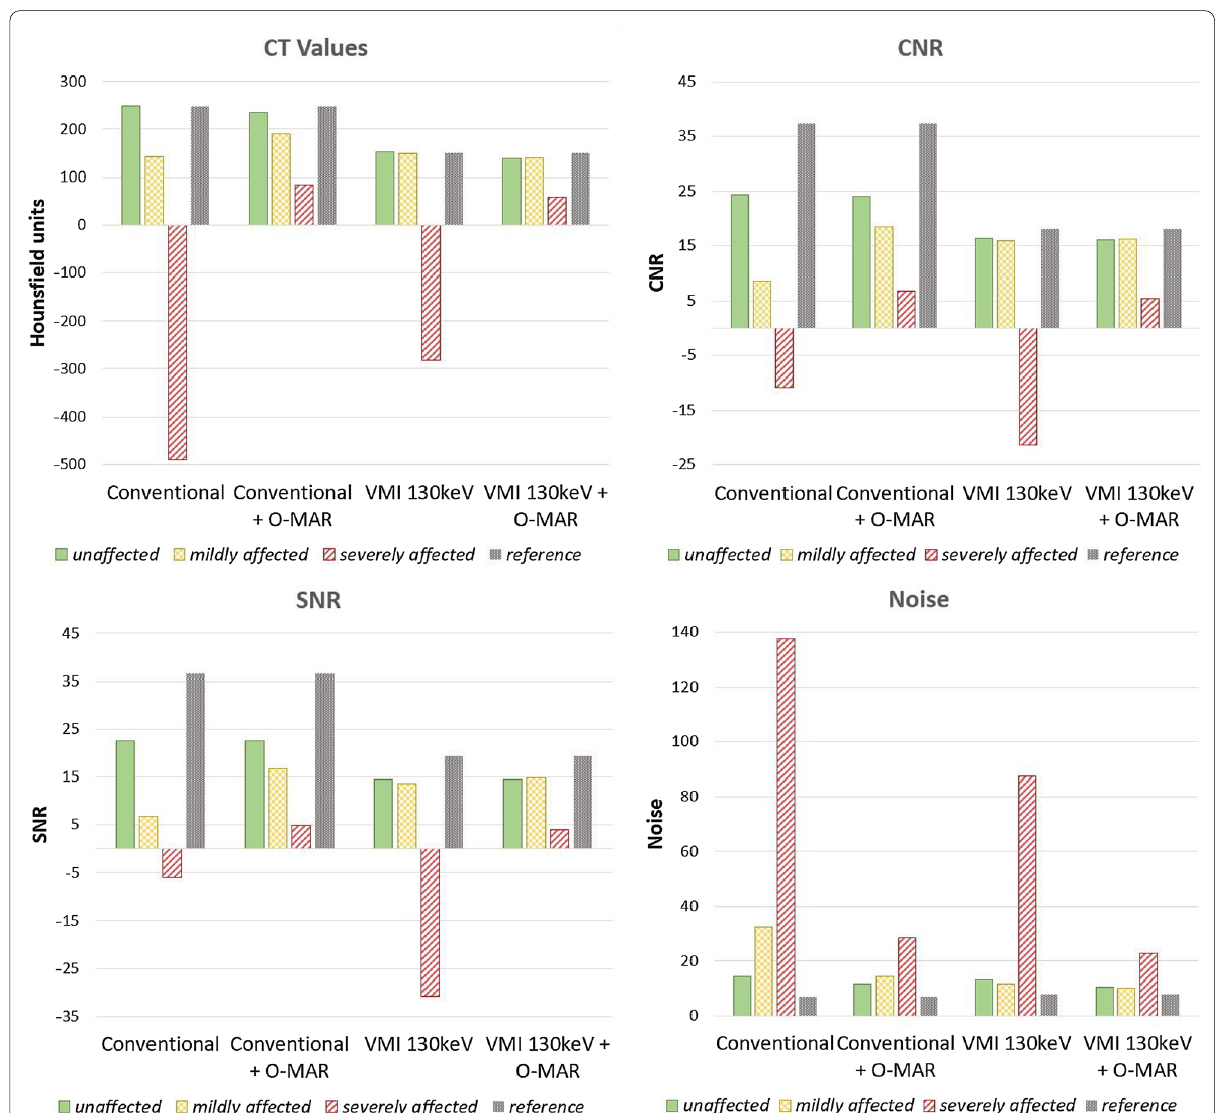
Fig. 7 CT values in Hounsfield Units, contrast-to-noise ratio (CNR), signal-to-noise ratio (SNR) and noise for the categorized pellets for conventional (140 kVp) imaging with and without O-MAR and 130 keV virtual monochromatic imaging with and without O-MAR. Pellets were categorized in unaffected, mildly affected and severely affected pellets. Reference values are the average values of all the pellets in the phantom without insertion of